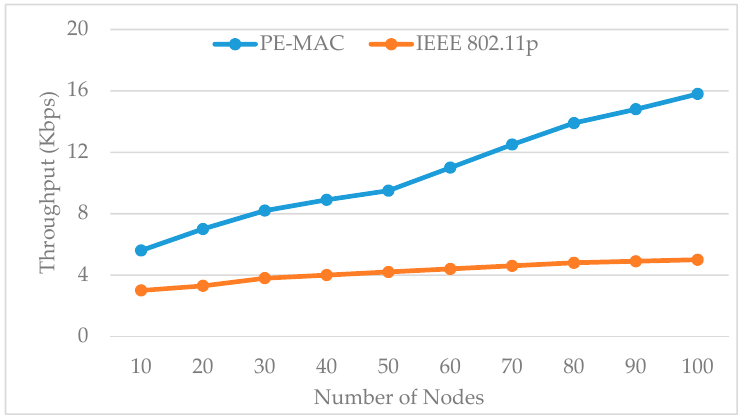
Figure 11. Impact of the number of nodes on throughput: proposed PE-MAC vs IEEE 802.11p.